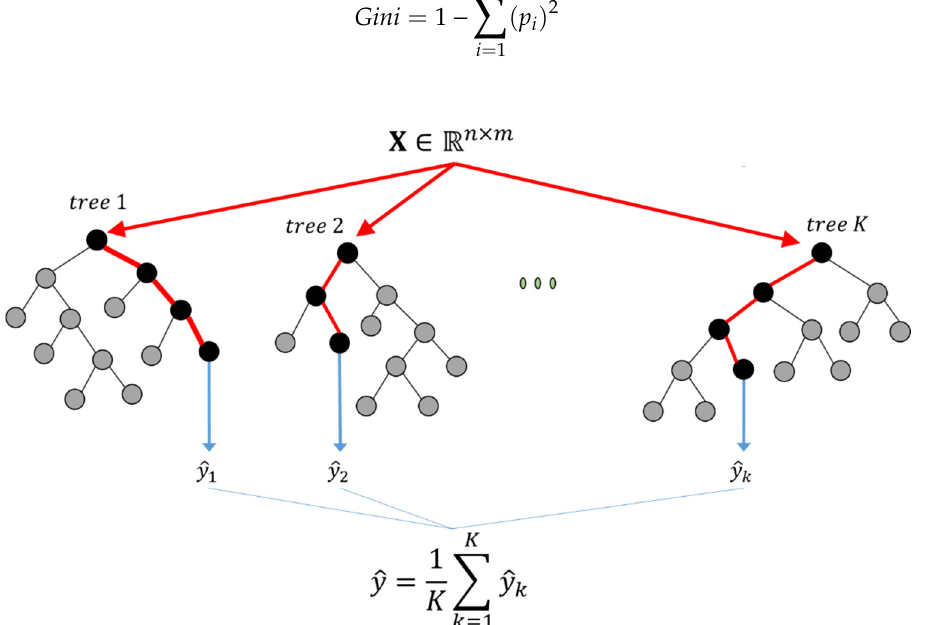
Figure 1. Diagrammatic representation of a random forest.